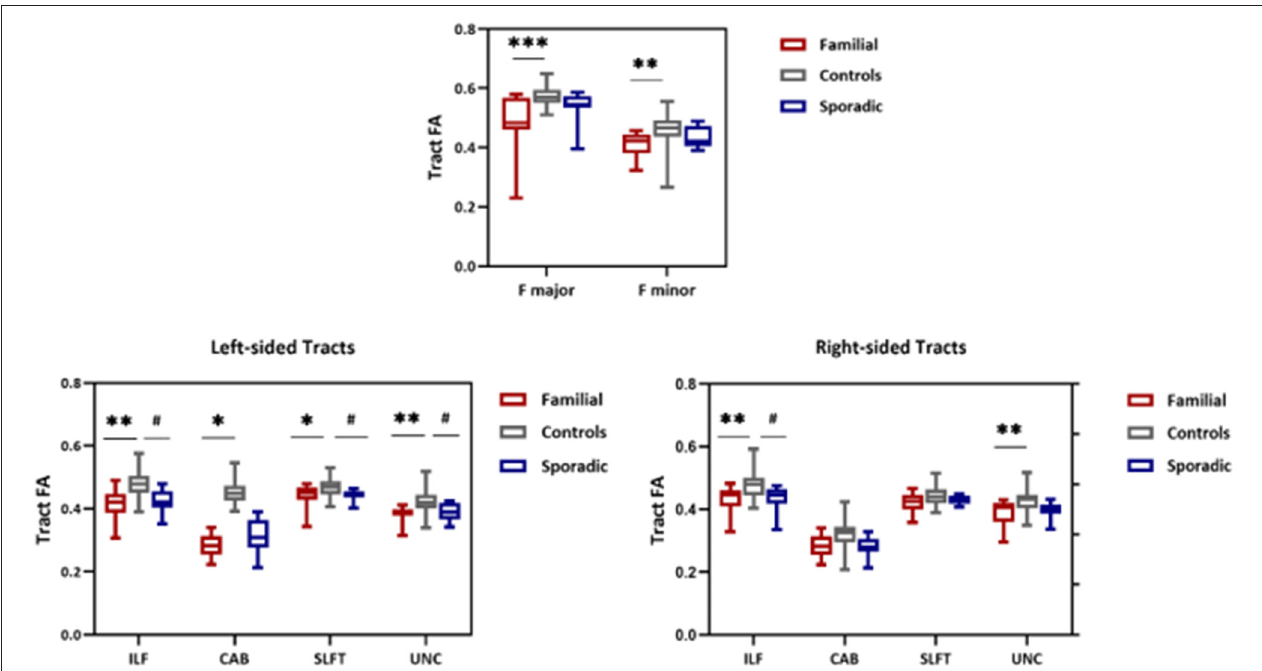
FIGURE 5 | FA values from TRACULA tracts Fmajor, Fminor, ILF, SLFT, UNC, and CAB. The plot shows mean FA left and right tracts and Fminor and major of patients with familial MS (red bars), controls (gray bars), and patients with sporadic MS (blue bars). Asterisks and number signs show significantly decreased FA values for patients when compared to controls. * p < 0.05; ** p < 0.01; # p < 0.05.